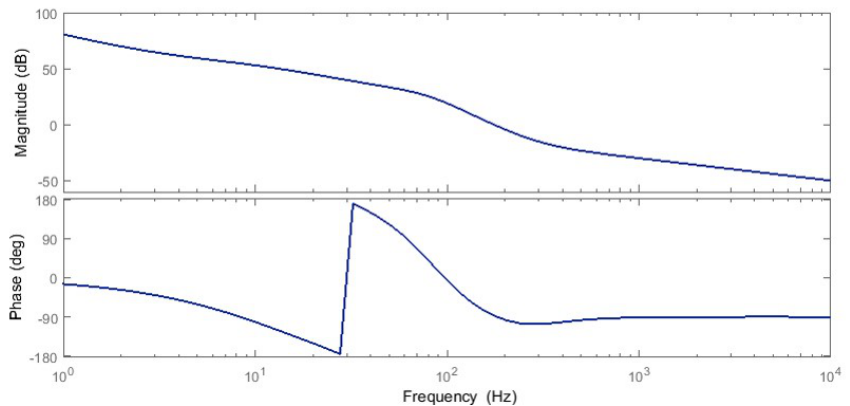
Figure 9. Bode plot of input impedance for droop-controlled